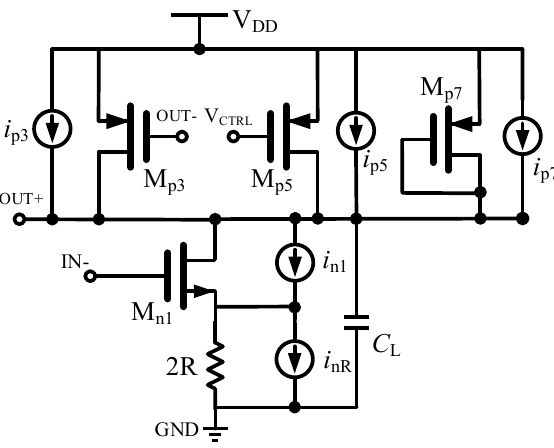
Figure 2. The equivalent half-circuit.